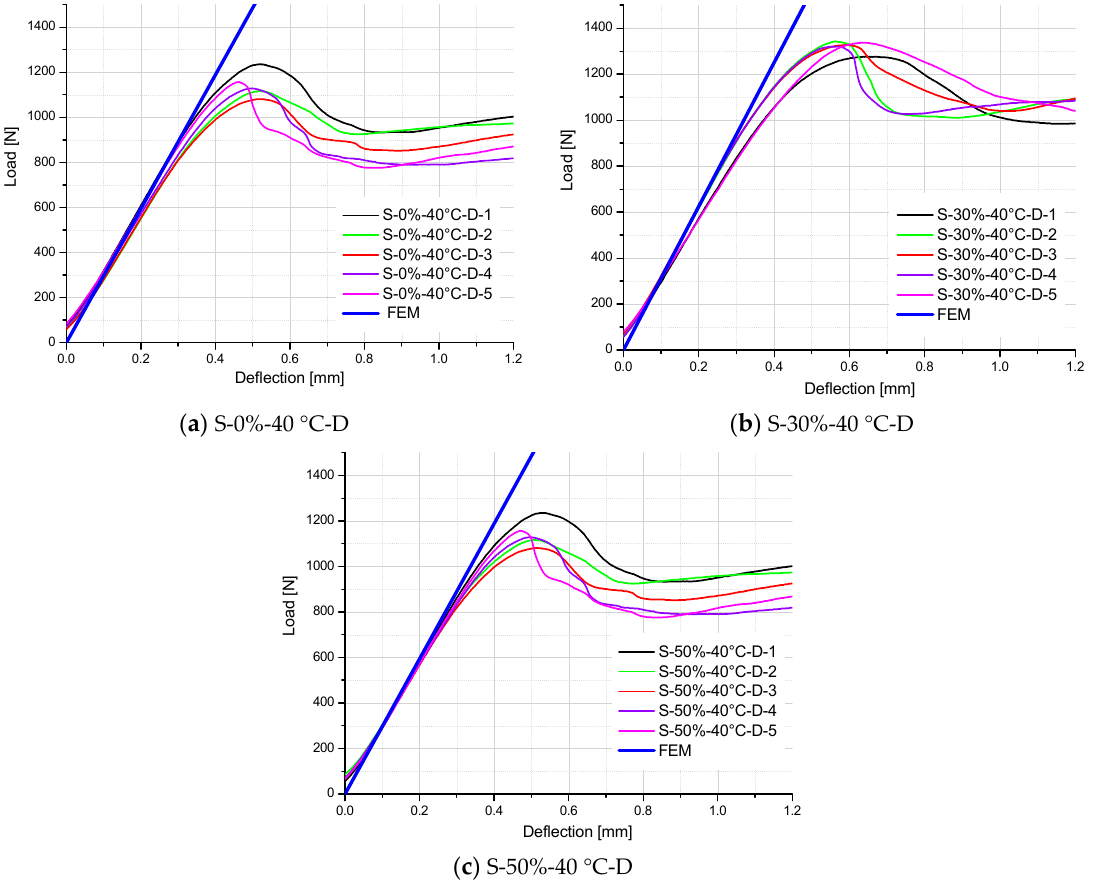
Figure 16. Comparison of load–deflection curves between FE analysis and test results of specimens tested at 40 °C and in the moisture desorption process. Table 6. Stiffness of specimens based on load–deflection curves (Unit: N/mm). FEM: finite element method.